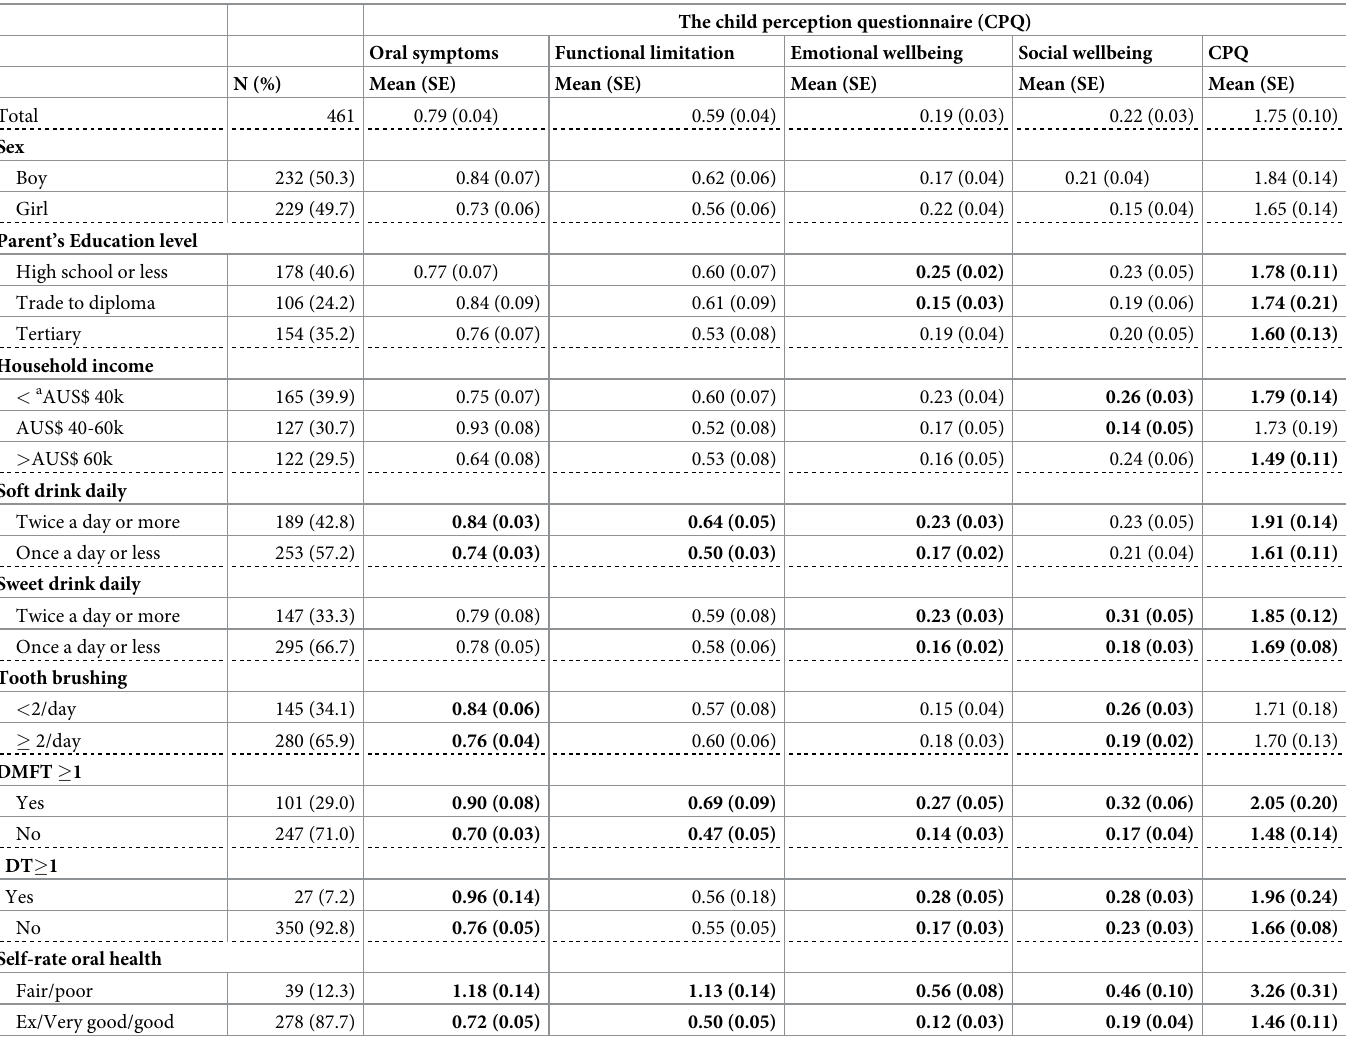
Table 6. Mean (SE) scores for 4-item CPQ and individual items by sample characteristics among children aged 11–13 years. The child perception questionnaire